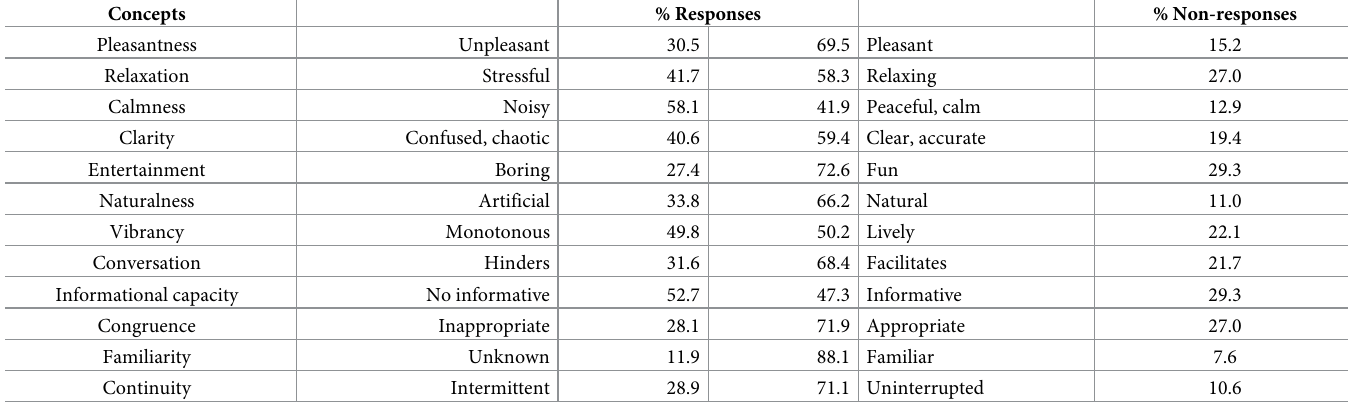
Table 2. Response distribution (%) of the scale version with two measurement attributes ( SCC-2A ) (n = 263).